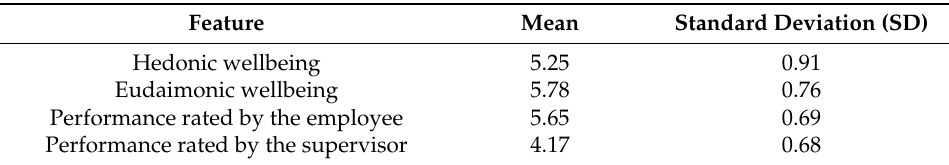
Table 2. Descriptive